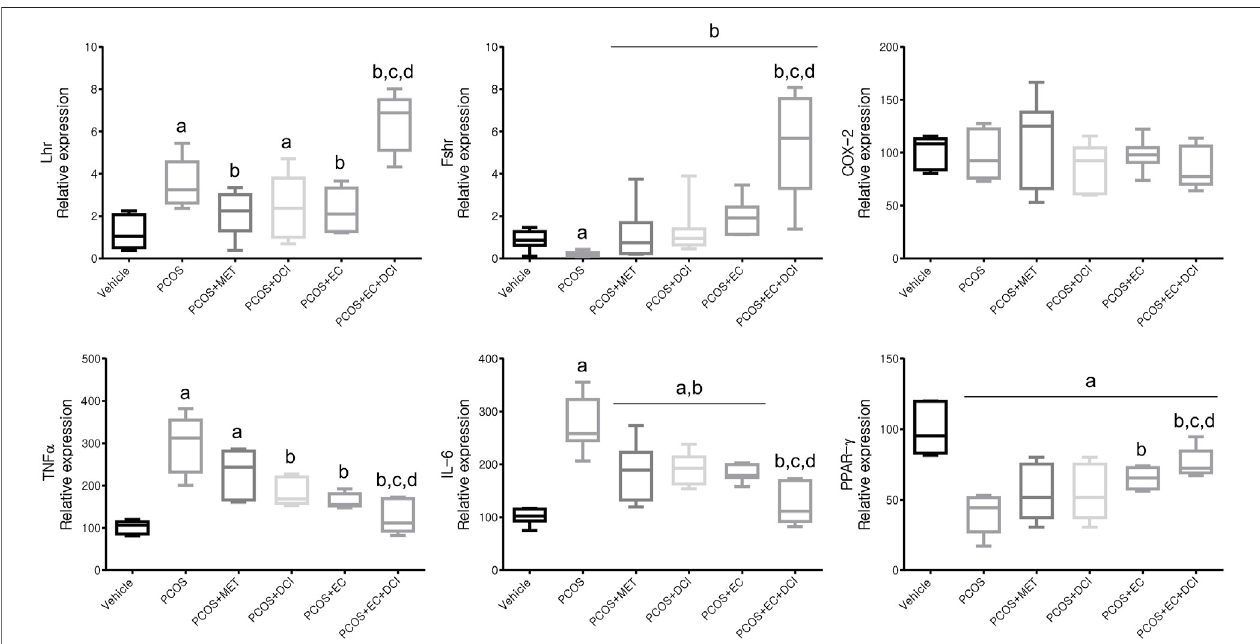
FIGURE 7 | Effect of EC extract and DCI on ovarian gene expression related to hormone receptors and in fl ammation in PCOS rats. Compared mRNA expression levels of Lhr , Fshr , COX-2, TNF α , IL-6, and PPAR γ from the ovaries of each experimental group as assessed by quantitative Real-Time PCR. Rplp0 was used as an internal control gene. All values represent means ±SD. a p < 0.05 vs. vehicle, b p < 0.05 vs. PCOS, c p < 0.05 vs. PCOS + DCI, d p < 0.05 vs. PCOS + EC. MET, metformin; EC, Ecklonia cava K.; DCI, d-chiro